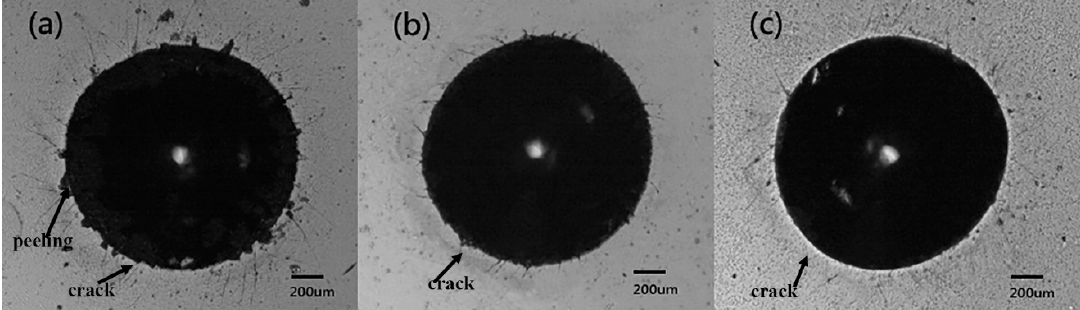
Figure 2. ( a ) X-ray di ff raction (XRD) spectrum of the three coatings coated HSS substrates and XP-spectrum of ( b ) AlCrMoN coating coated HSS substrates, ( c ) AlCrVN coating coated HSS substrates.